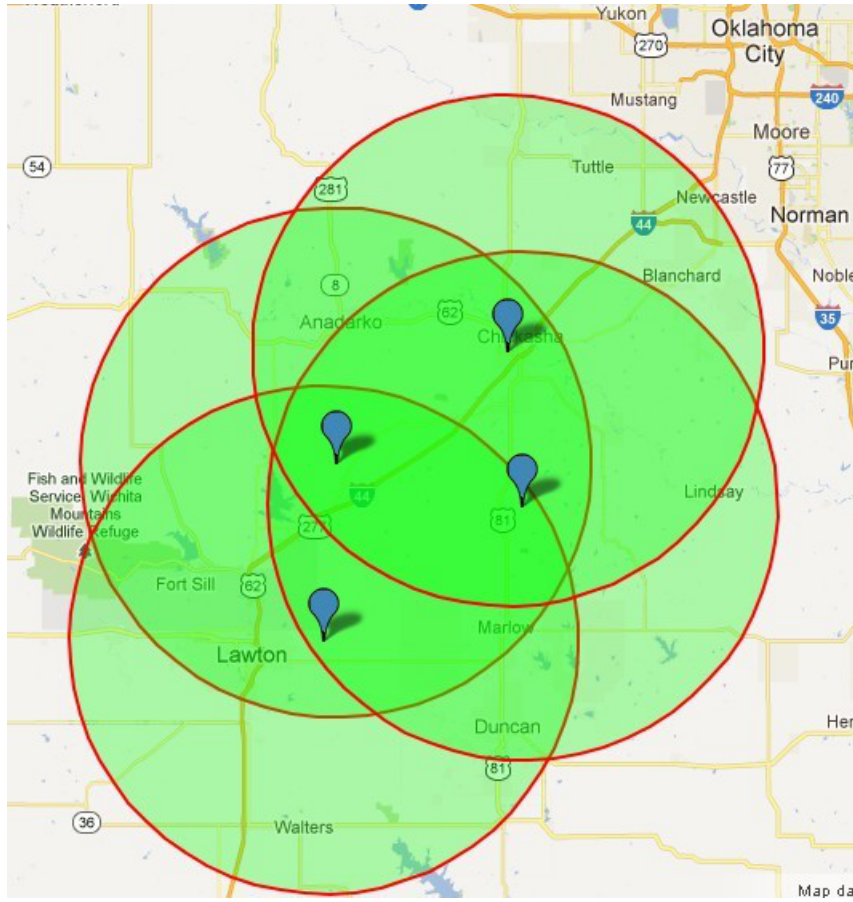
Fig. 2. The layout and location of the IP1 weather radar network. The coverage circles of IP1 radar are in radius of